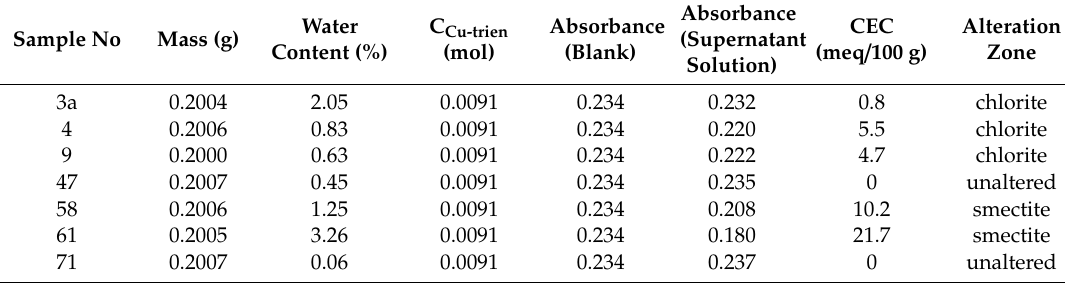
Table 1. Results of CEC analysis of the seven core samples.